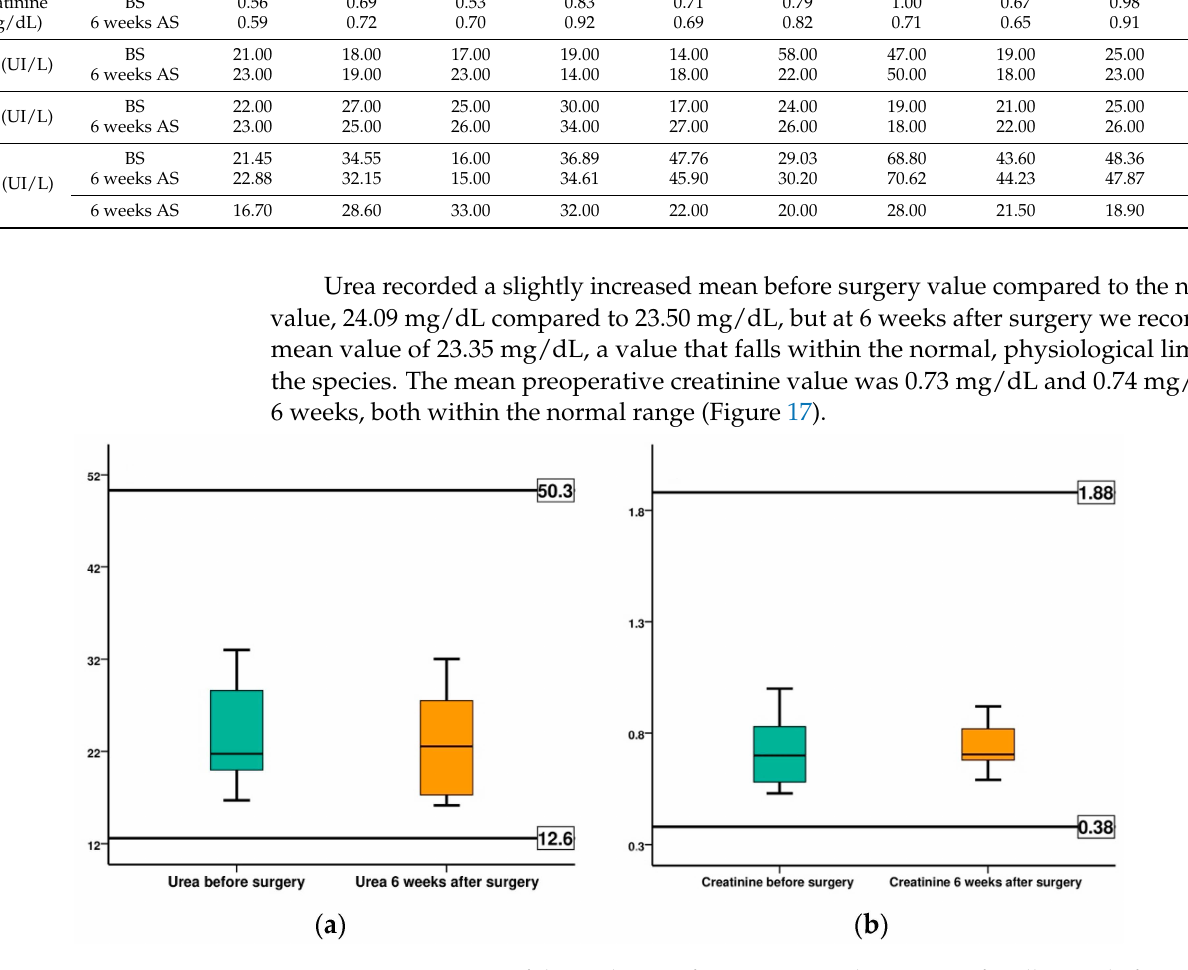
Figure 17. Comparison of the evolution of serum urea and creatinine, for all cases, before surgery (BS) and at 6 weeks after surgery (AS): ( a ) serum urea; ( b ) creatinine. The evolution of liver function indicators, ALT and AST are shown in Figure 18. Both ALT and AST recorded mean values before surgery and at 6 weeks after surgery in the normal range, being 25.8 IU to 23.2 IU for ALT and 23.3 IU to 24.8 for